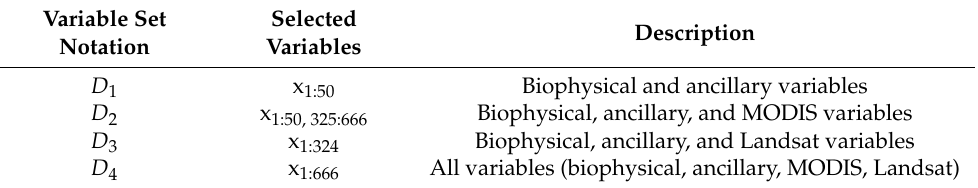
Table 3. Sets of continuous predictor variables used in all